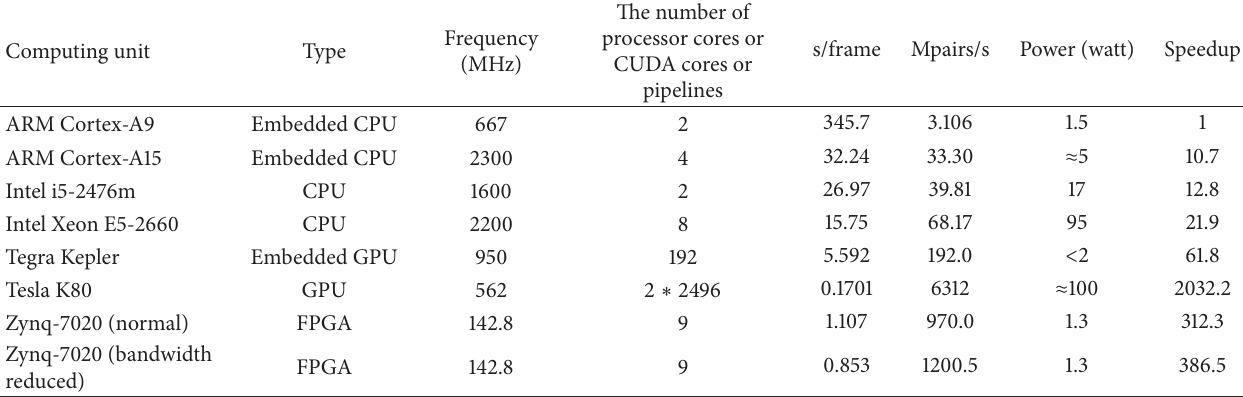
Table 3: Calculating the potential in 32 × 32 × 32 particle-mesh with different